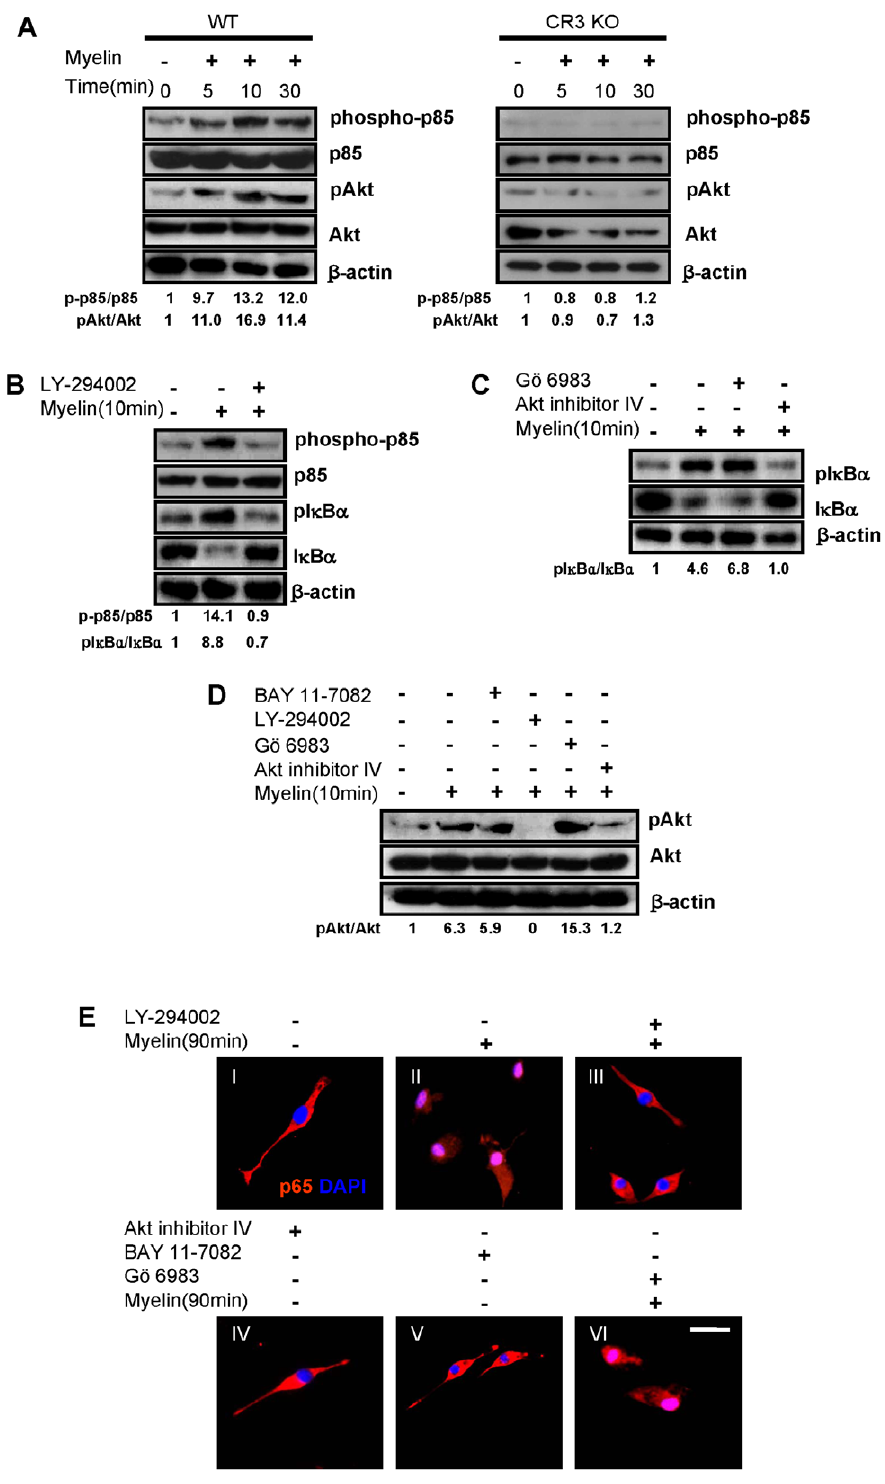
Figure 8. Effect of myelin on activation of PI3K/Akt pathway. (A) Phosphorylation of p85 and Akt in bone marrow-derived macrophages from WT and CR3 KO mice treated with myelin for the indicated time. (B) Effect of PI3K inhibitor LY-294002 on myelin-induced I k B- a phosphorylation and degradation in macrophages. (C) Effect of Akt inhibitor IV on myelin-induced I k B- a phosphorylation and degradation in macrophages. (D) Effect of inhibitors of PI3K, Akt, NF- k B and PKC on myelin-induced Akt phosphorylation in macrophages. (E) Macrophages were pretreated with inhibitors of PI3K, Akt, NF- k B and PKC for 30 minutes, respectively and then incubated with myelin for 90 minutes. Myelin-induced p65 translocation in macrophages was detected by immunofluorescent staining. p65 was stained red and nuclei were stained with DAPI (blue) (Scale bar=10 m m). All inhibitors were used for 30-minute pre-incubation before myelin incubation. Phosphorylation levels were normalized to non-phosphorylated total proteins. Similar results were obtained from three independent experiments.